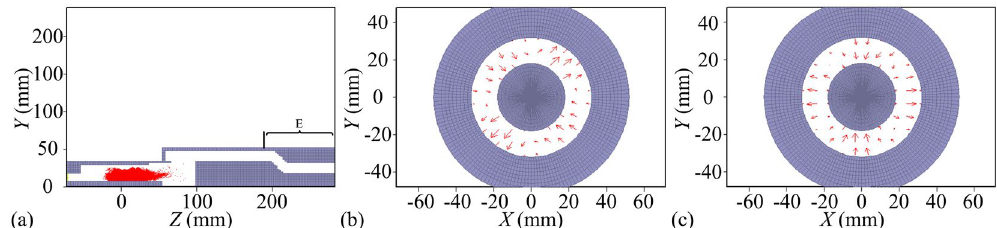
Figure 8. ( a ) Electron spokes in the RZ plane of the ten-cavity RM with section E replacing section D. ( b ) TE 21 mode in the output port at 28.954 ns. ( c ) TE 21 mode in the output port at 29.996